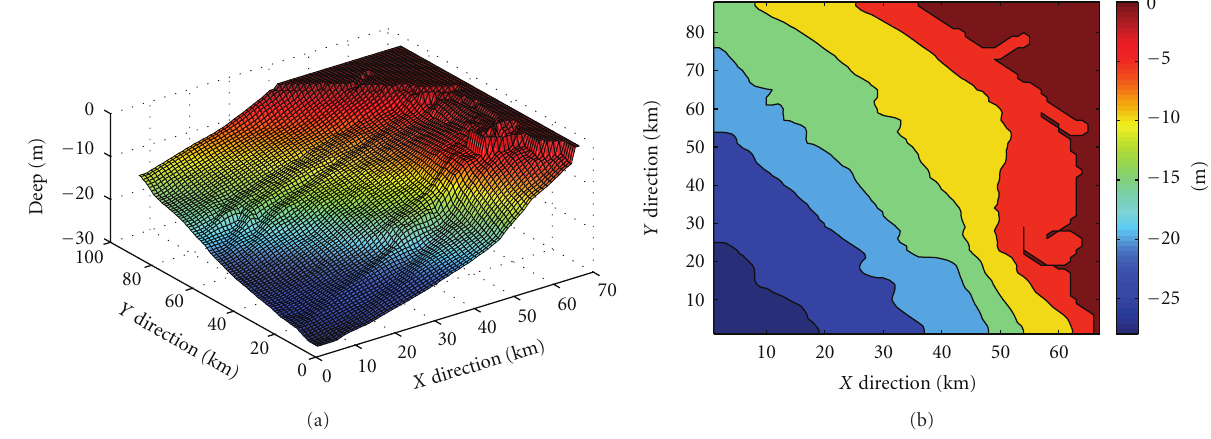
Figure 11: Grid map (a) and the bottom topography contour (b).